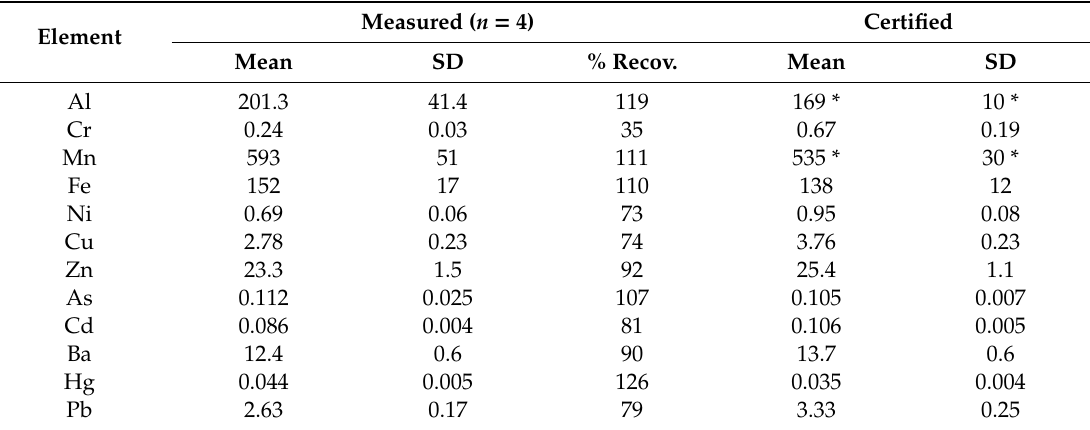
Table 1. Measured, certified and recommended values of four samples of M2 reference material. All values in µ g g − 1